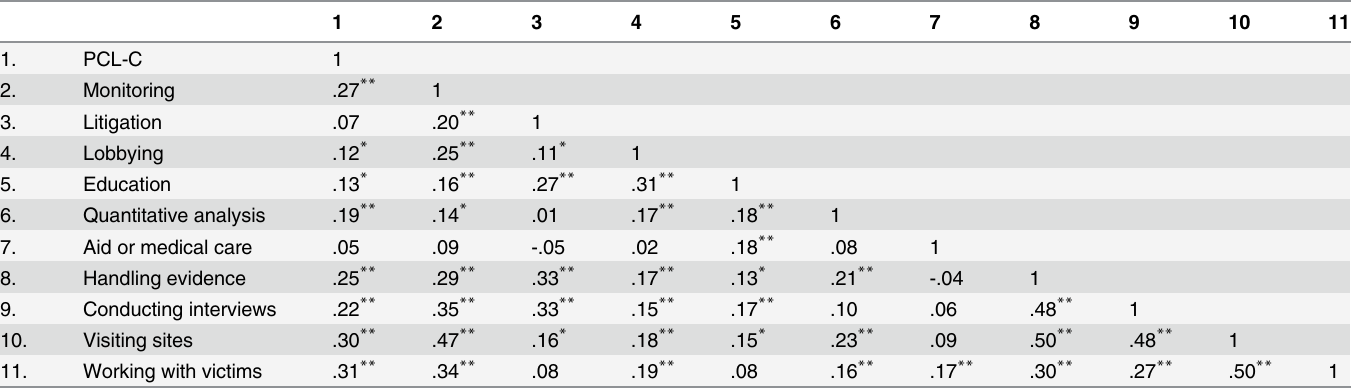
Table 3. Correlations between occupational task and symptoms of PTSD.